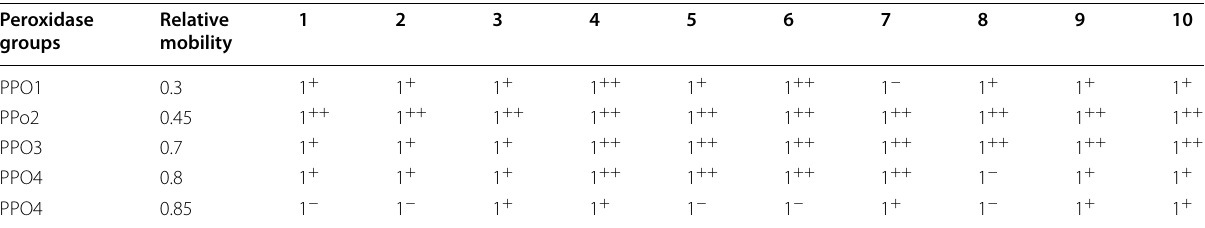
Table 4 Isomers of polyphenoloxidase (PPO) izoenzymes and their Retention factor (Rf) in response to F. oxysporum and endophytic isolates